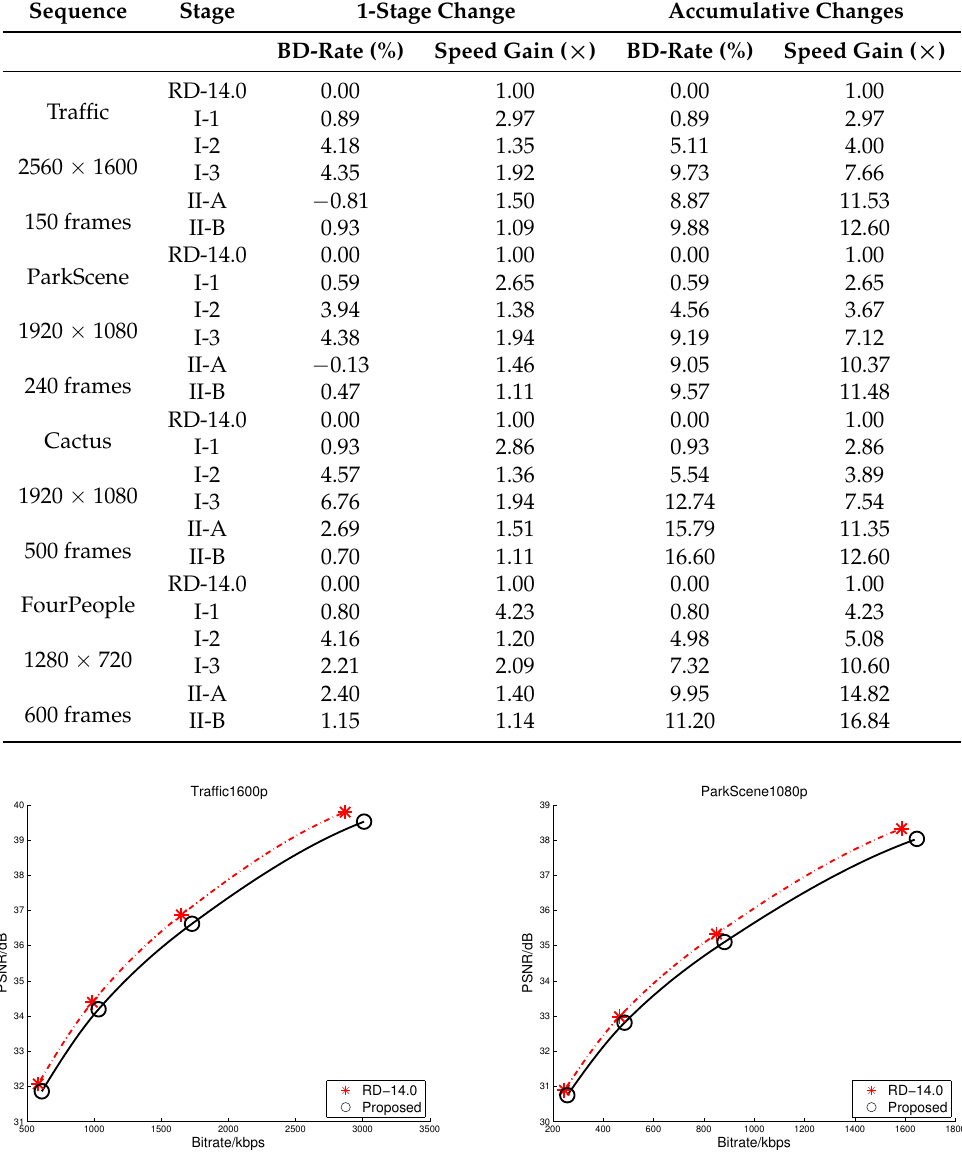
Table 2. Performance in stages of proposed transcoding algorithms.